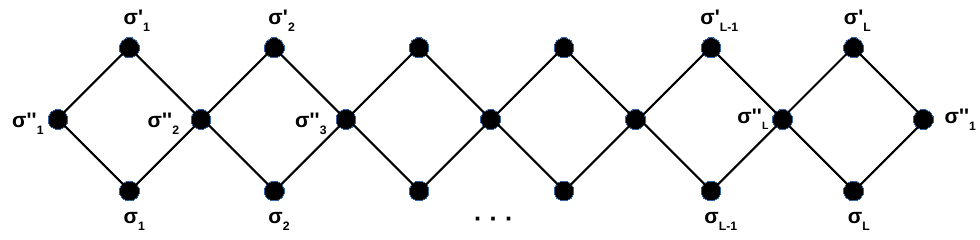
Figure 3 . The transfer matrix. Sum over all middle spins (cid:27) 00 is